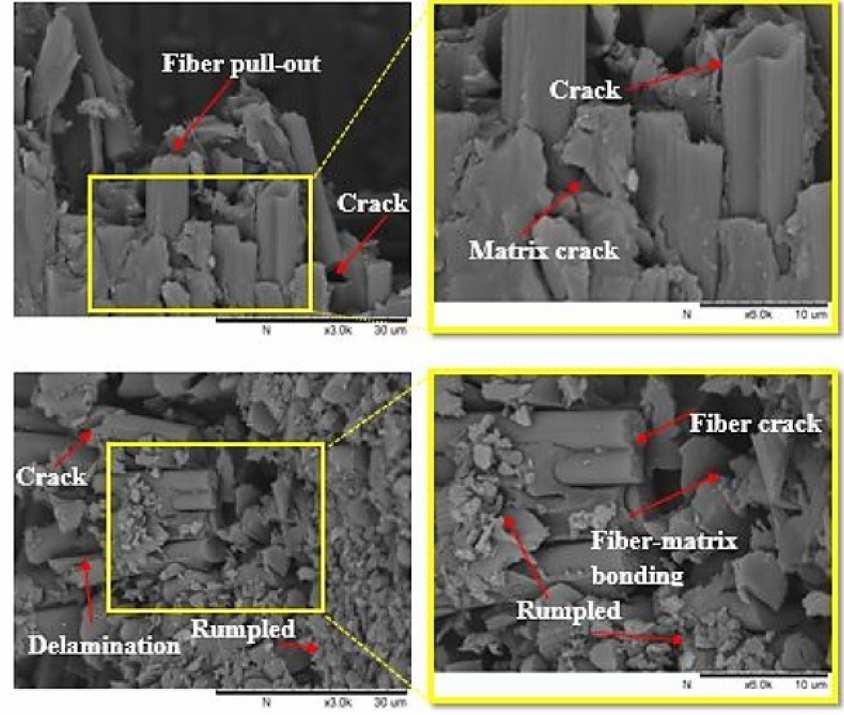
Figure 15. Low- and high-magnification SEM images of the fractured surfaces of the composite laminates at the face side after impact